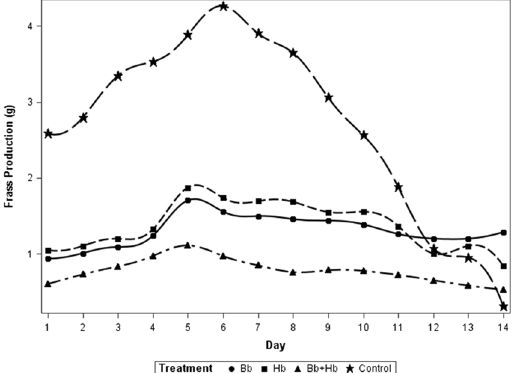
Figure 2. Frass production (g) in last instar larvae of Rhynchophorus ferrugineus when treated with B. bassiana (1 × 10 4 spore ml − 1 ) and H. bacteriophora (50 IJs ml − 1 ); (Bb: Beauveria bassiana , Hb: Heterorhabditis bacteriophora , IJs: Infective Juveniles).